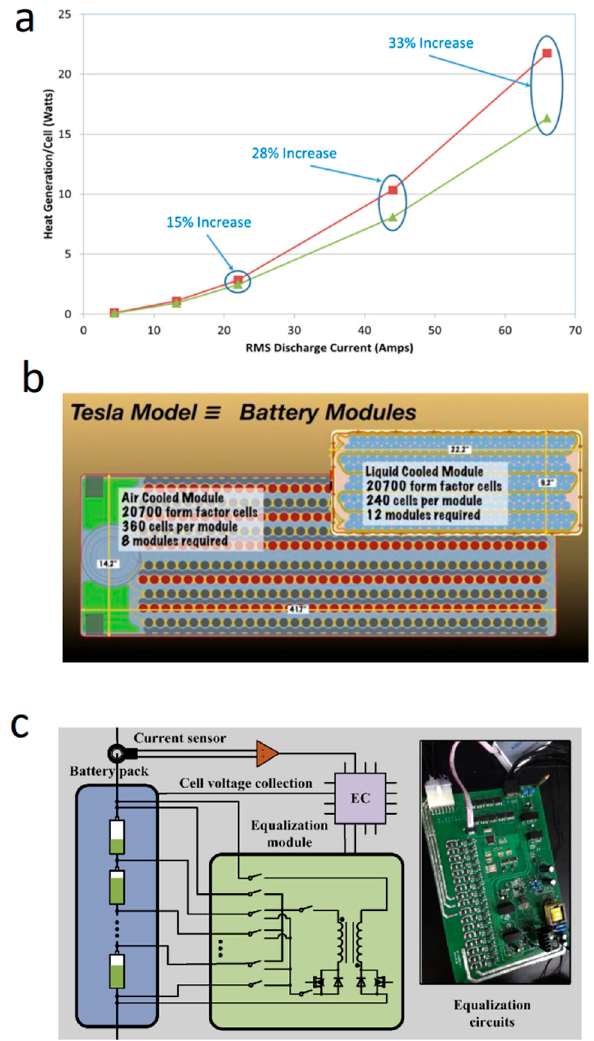
Figure 4. Heat generation normalized on a cell basis for a single cell and a 10-cell lithium-iron-phosphate module [6] ( a ); Tesla Model 3 Wins On Innovative Simplicity (htps://seekingalpha.com/article/3975416-tesla-model-3-wins-innovative-simplicity) ( b ); Block diagram for equalization [32] ( c ). Reproduced by permission of Elsevier.